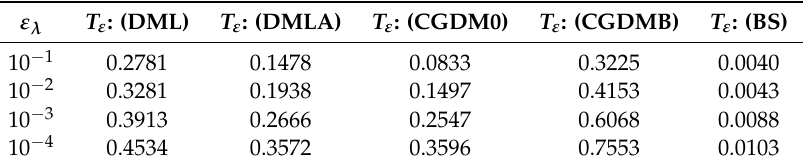
Table 10. Results for Case EQ with J = 510, m = 25.